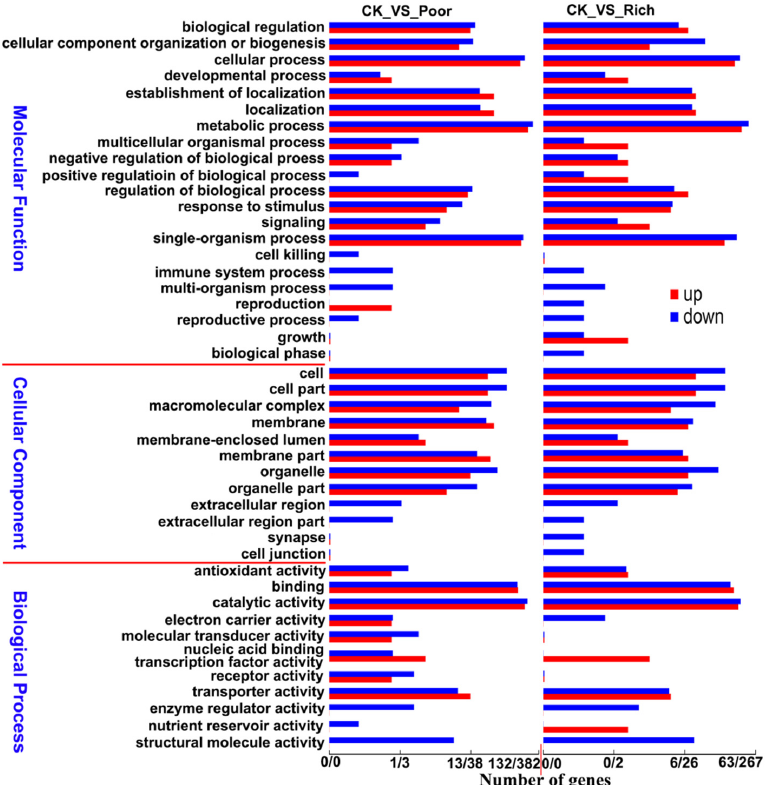
Figure 2. GO classification enrichment analysis of the differentially expressed genes.